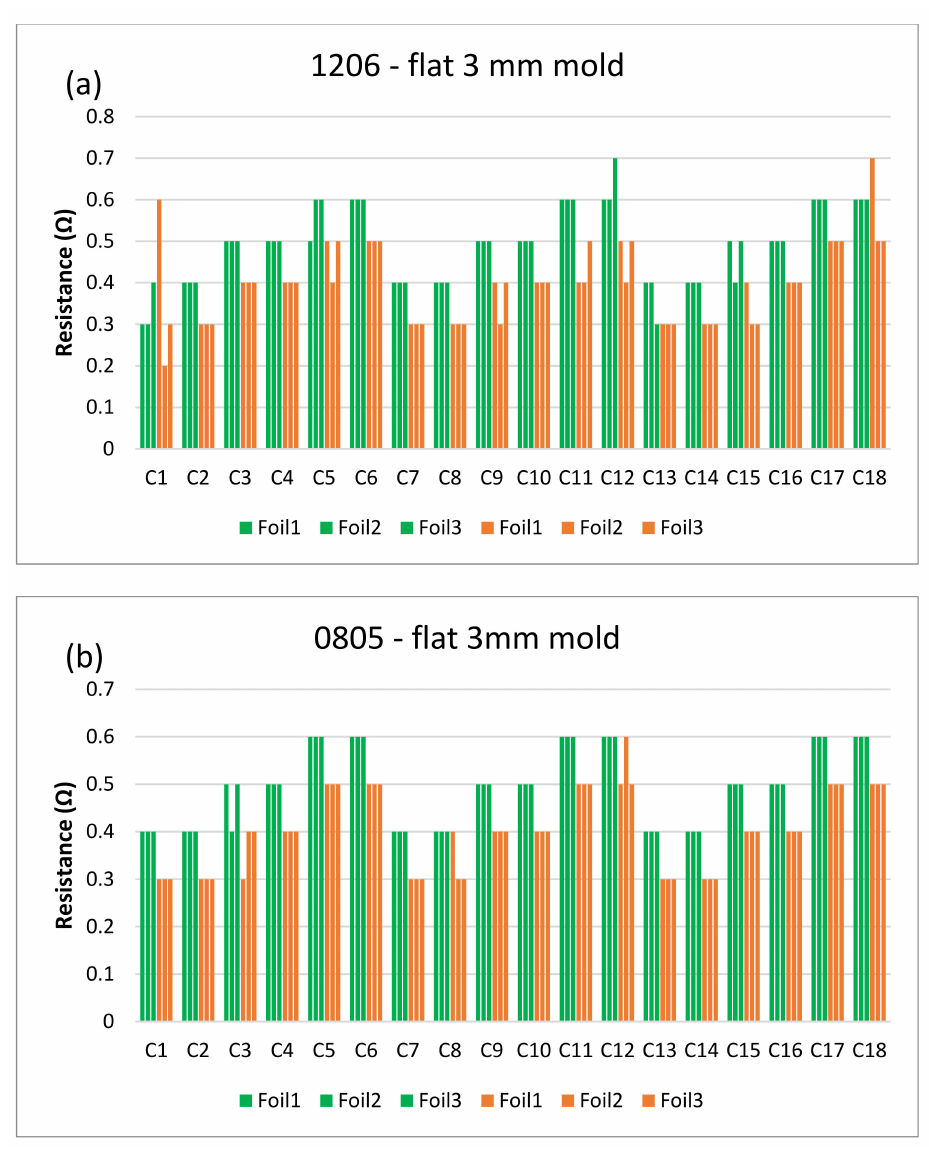
Figure 34. Resistance measurements for 1206 resistors ( a ) and 0805 resistors ( b ) molded in the 3 mm flat